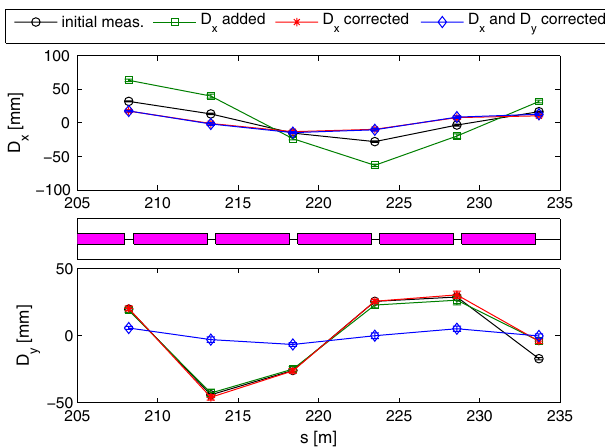
FIG. 6. (Color) Measured dispersion in the undulator for the different